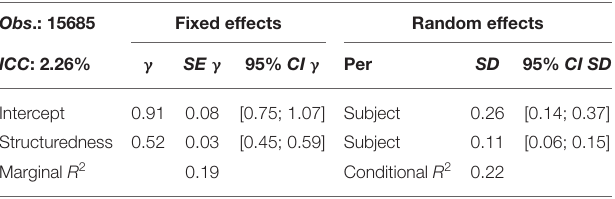
TABLE 1 | Random coefficient model with the dependent variable global rating for eleven school subjects. Obs .: